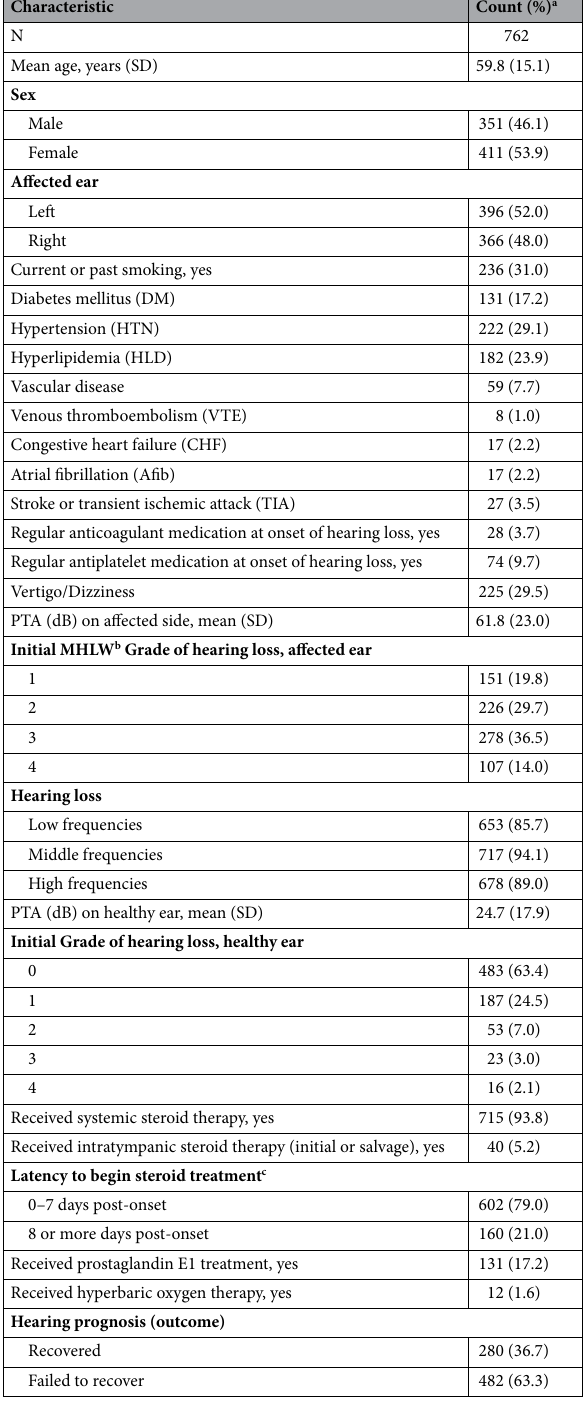
Table 1. Characteristics of study participants with ISSNHL. SD, standard deviation; PTA, pure tone audiogram; PTA values represent the arithmetic mean of hearing threshold (measured in dB) obtained at 5 test frequencies (250, 500, 1000, 2000, 4000 Hz). a Unless otherwise indicated, values are counts (percentage); N represents patients who had unilateral ISSNHL and who had no evidence of vestibular schwannoma. b Criteria of the Sudden Deafness Research Committee of the Ministry of Health, Labour and Welfare. c Some patients never received steroid treatment; they were manually assigned to the 8-or-more-days